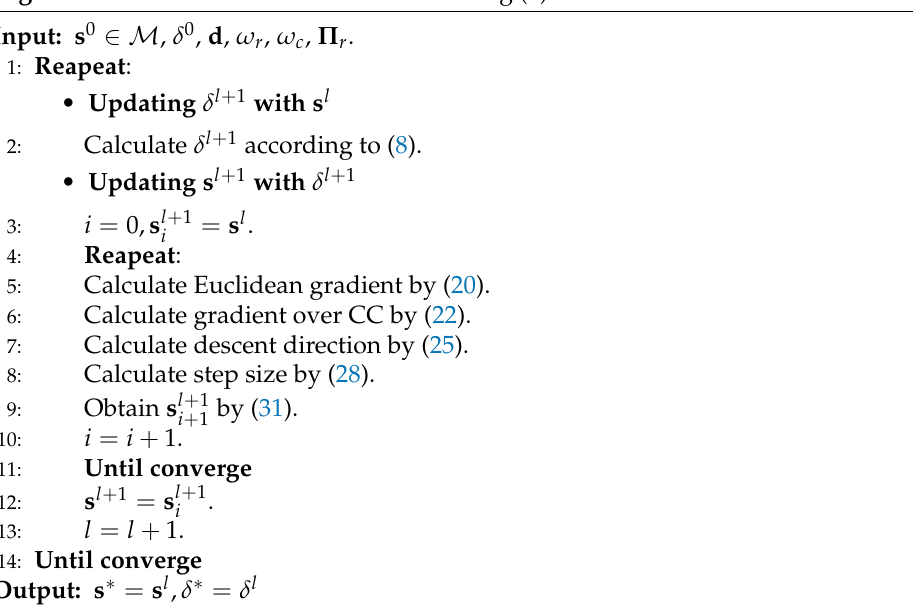
Algorithm 1 : The DBMWR method for solving